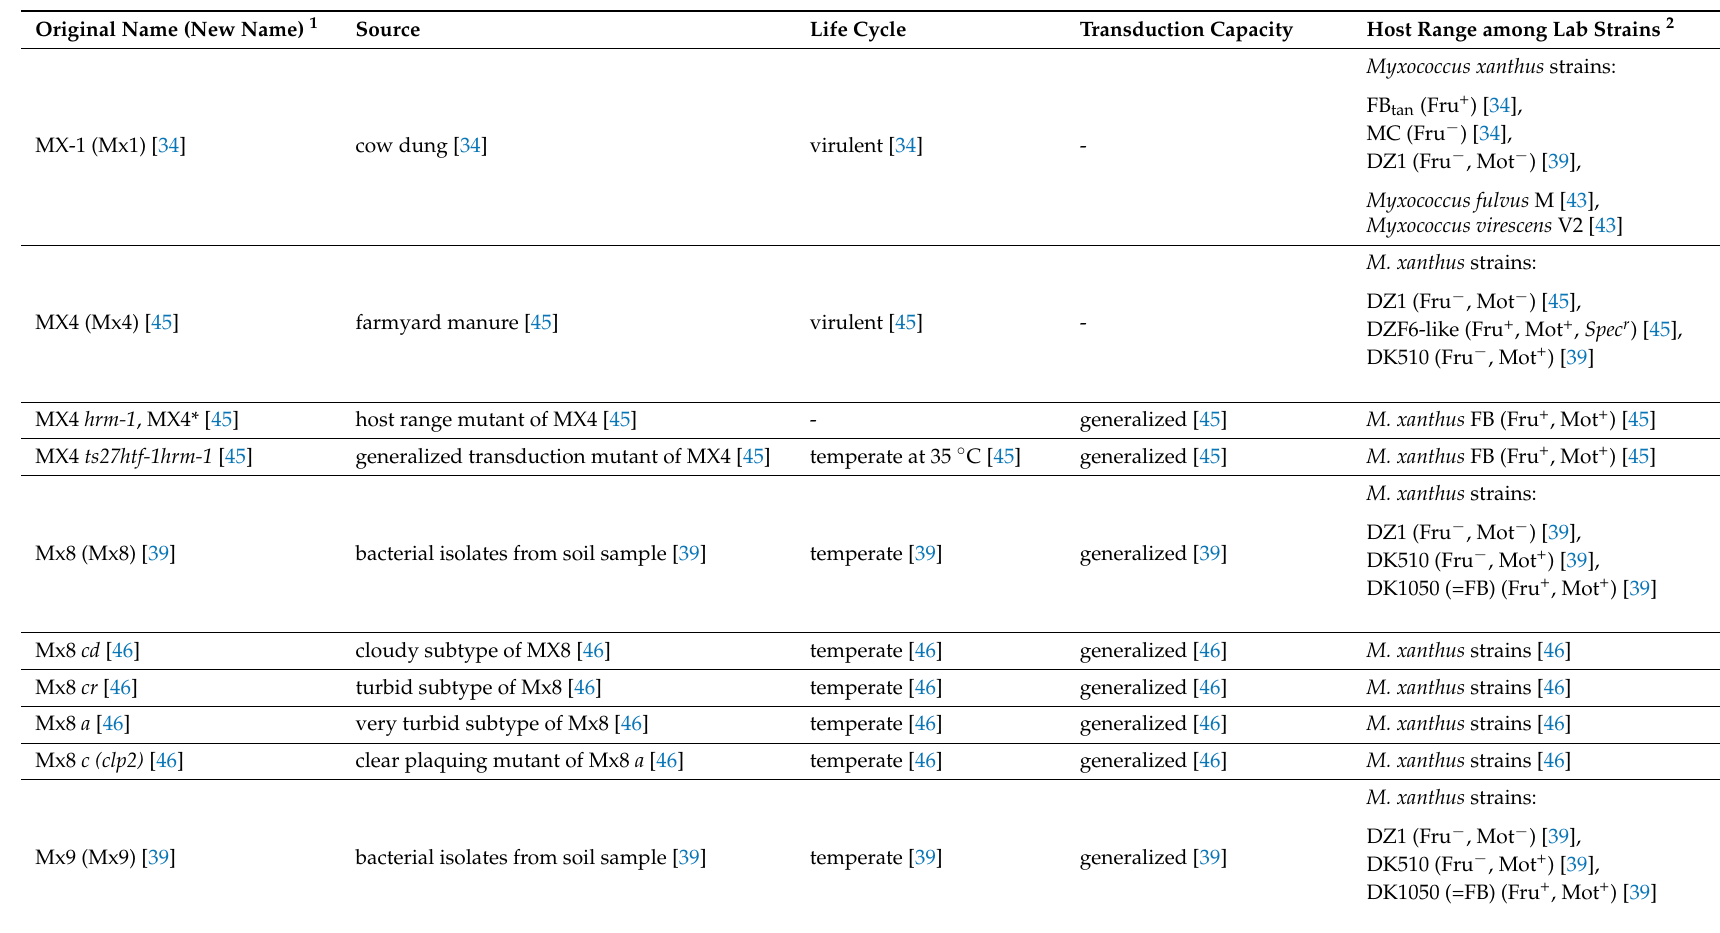
Table 1. Overview of well-described bacteriophages of